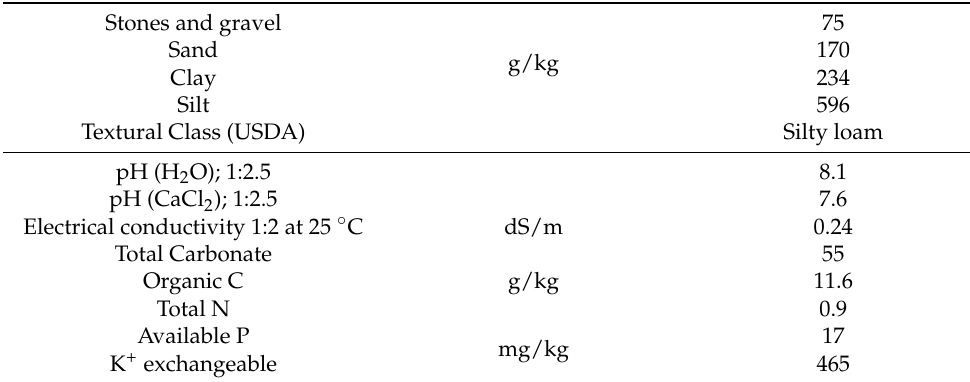
Table 1. Physical and chemical characteristics of the